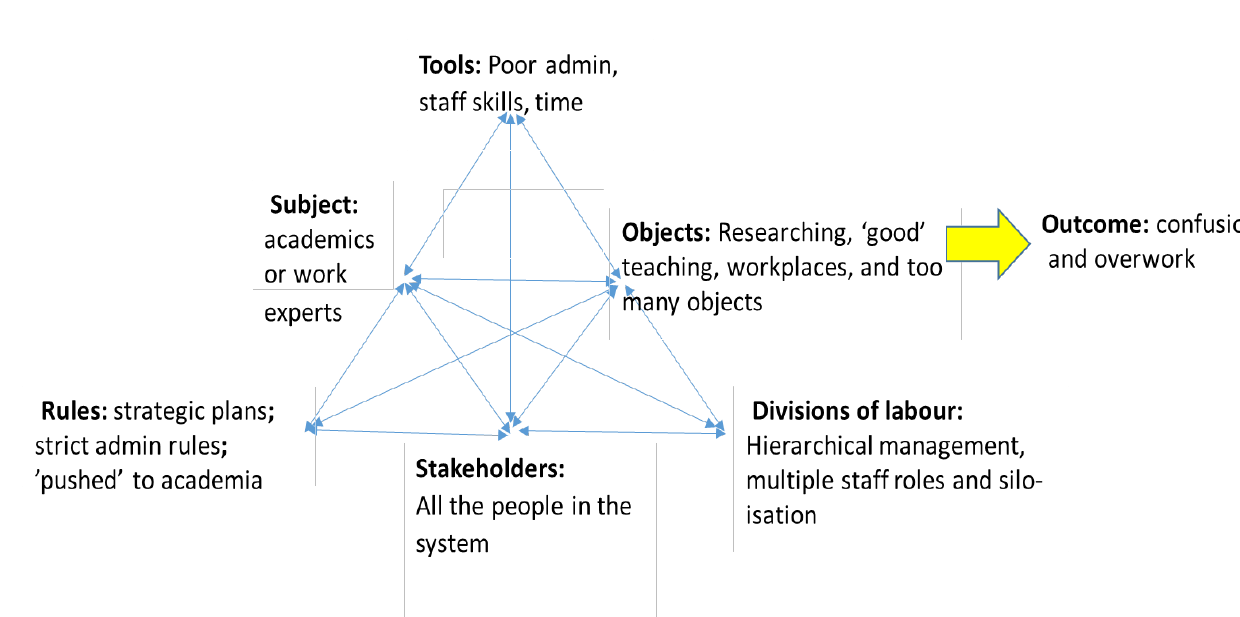
Figure 3 : Activity system analysis of the present